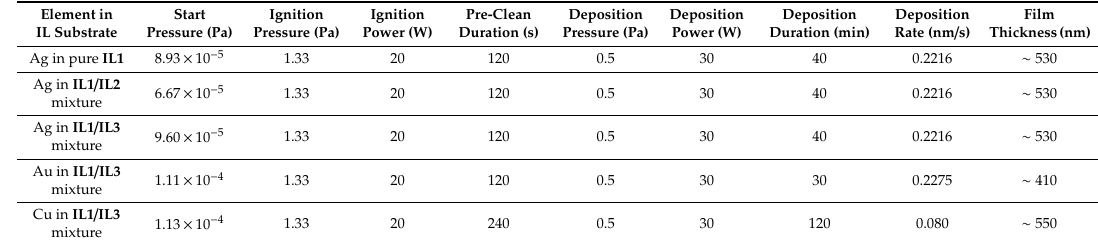
Table 2. Sputter deposition parameters. For parameters of Ag deposition in IL2 and IL3 , see Meyer et al. [23]. For parameters of Au and Cu deposition in IL1 , see Meischein et al. [25]. Elementin Start Ignition Ignition Pre-Clean Deposition Deposition Deposition ILSubstrate Pressure(Pa) Pressure(Pa) Power(W) Duration(s) Pressure(Pa) Power(W)